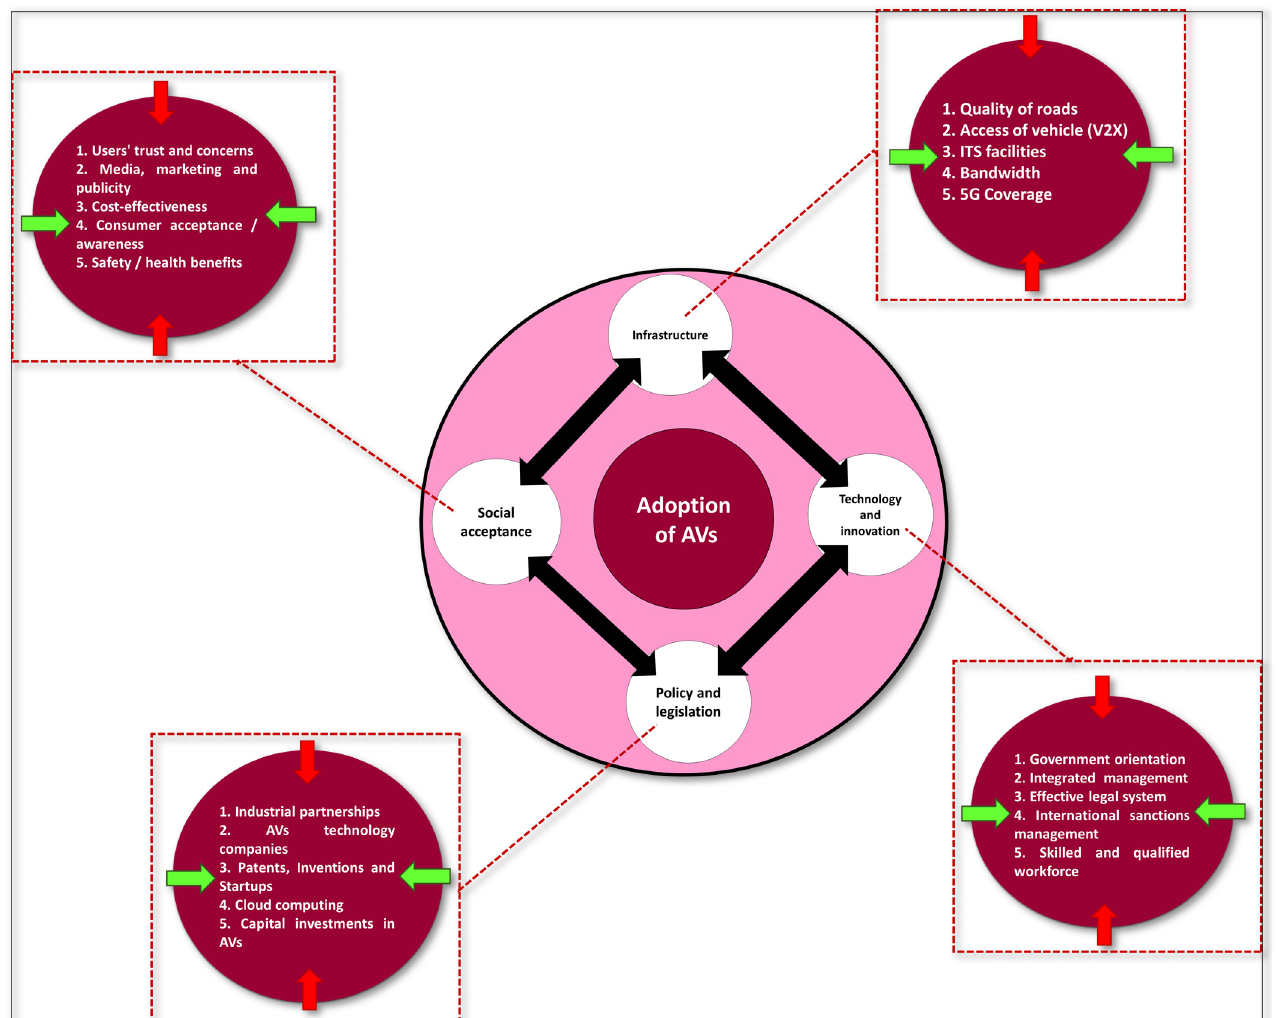
Figure 1. Conceptual framework of AV adoption .